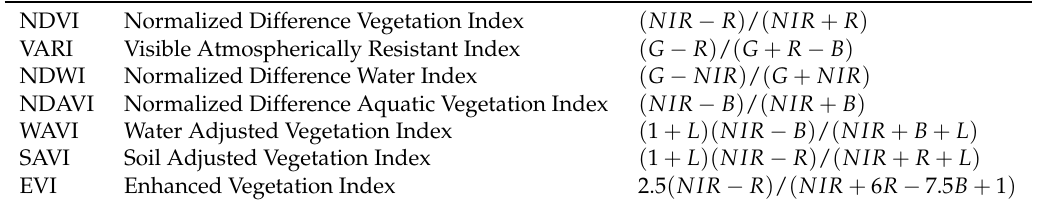
Table 3. Vegetation index definitions, where B , R , G and NIR are blue, red, green and near-infrared reflectance respectively, and L =